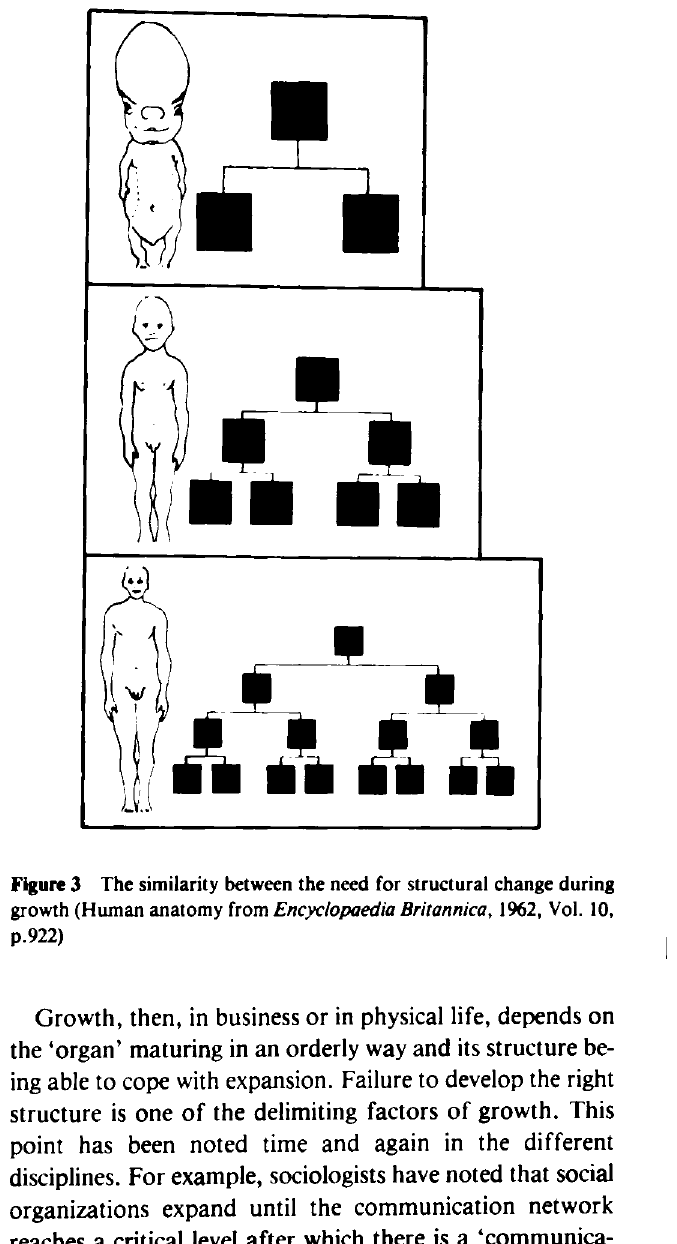
Figure 3 The similarity between the need for structural change during growth (Human anatomy from Encyclopaedia Britannica, 1962, Vol. 10,